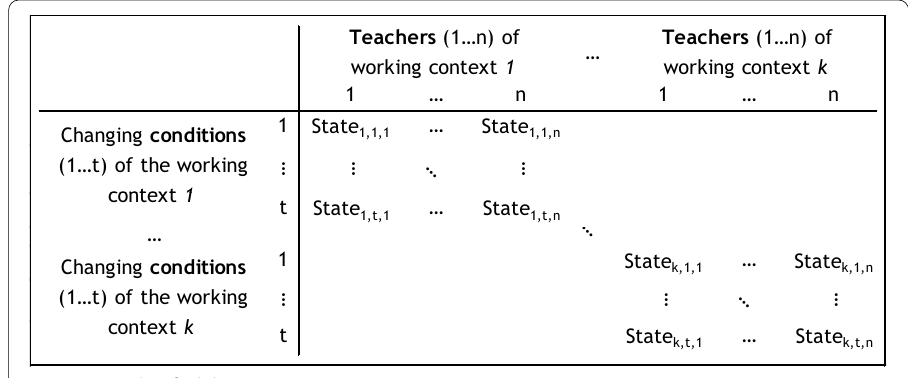
Fig. 5 Cross-classified data